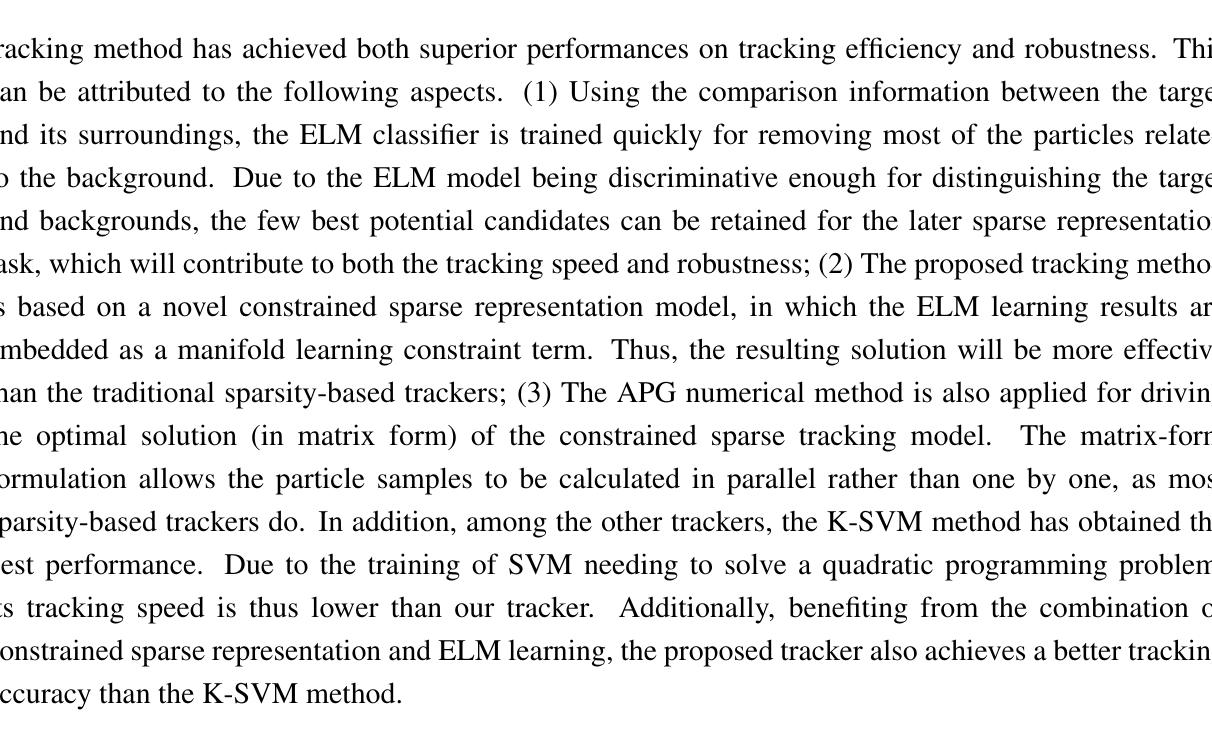
Table 2. Performance comparisons in terms of center location error (CLE) (in pixels) and VOC overlap rate (VOR) ( % ). The best results are shown in bold and red fonts. MIL, multiple instance tracker; CT, compressive tracker; Frag, fragments-based tracker; APG, accelerated proximal gradient.